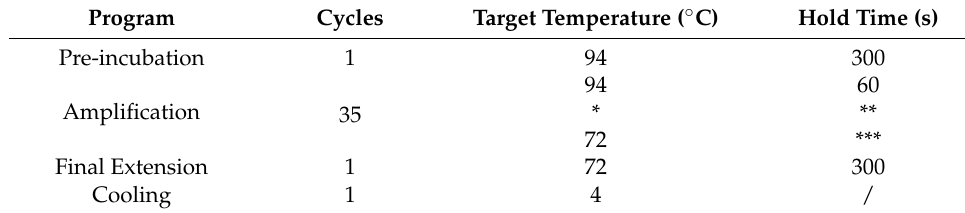
Table 4. PCR amplification